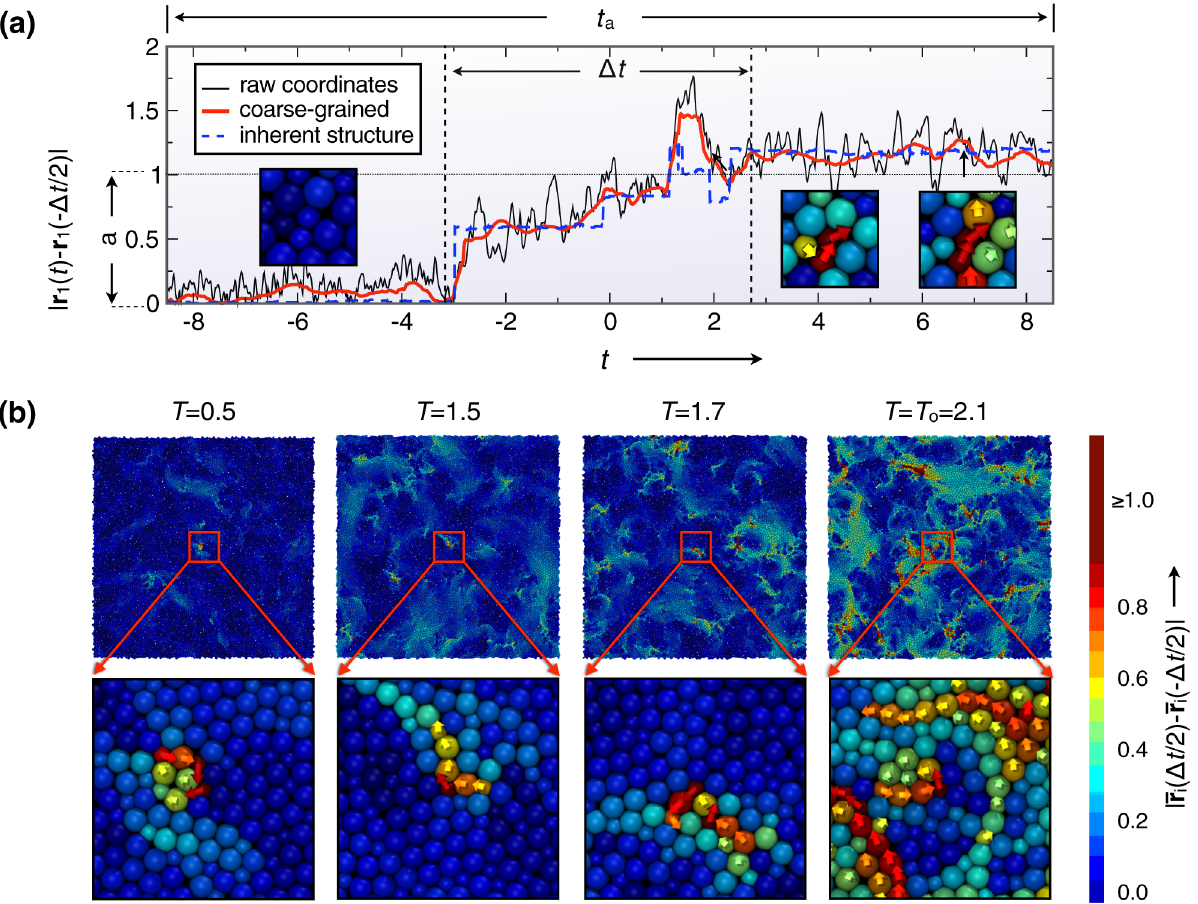
FIG. 1. Excitations can be identified from dynamical processes localized in space and time. Here, identifications are illustrated with rendered representative trajectories for the 2D- 68:32 system (models in Table I). The unit of length is (cid:3) and the unit of time is ð (cid:5)=m(cid:3) 2 Þ (cid:1) 1 = 2 ; i.e., see text. (a) The upper panels shows the displacement for the unprocessed coordinate of a tagged particle at time t ð t Þ (cid:1) (cid:2) r ð(cid:1) (cid:1) t= 2 Þj . together with that displacement in the inherent-structure coordinate and in the time-coarse-grained structure, i.e., j (cid:2) r 1 1 Here (cid:1) t is the instanton time and t a is the plateau time. The averaging window used is (cid:6)t ¼ 0 : 6 . The snapshots are drawn to show the space-filling sizes of particles and are colored to indicate the distance of a particle from its position at t ¼ (cid:1) (cid:1) t= 2 . The arrows indicate the direction of that motion. (b) The lower panels show similarly rendered snapshots for the full 10 000-particle system over one instanton time for a tagged particle at the center of the box. Enlargements show detailed structures of the excitation dynamics, where arrows indicate the direction of the color-labeled displacements. Blue indicates relative immobility while red indicates relative mobility. The depictions are for particle density (cid:8) ¼ 0 : 75 at four different temperatures (as indicated). The glassy-dynamics–onset (cid:3) 2 : 1 temperature for this system at this density is T o